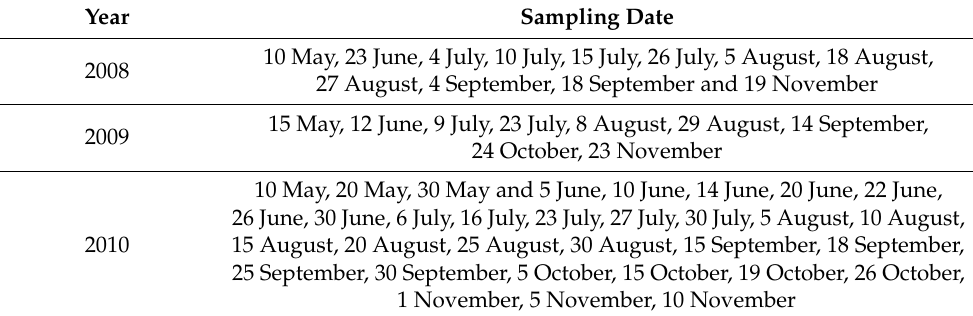
Table 3. Specific sampling